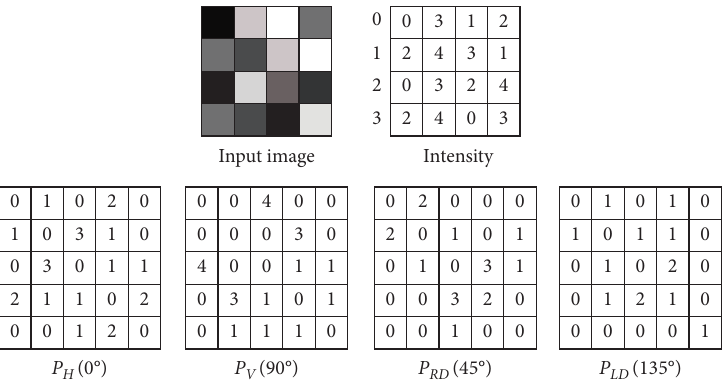
Figure 1: Co-occurrence matrix generation for N